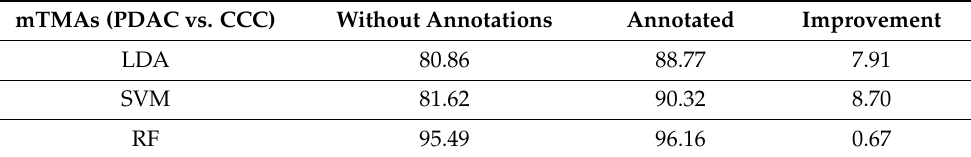
Table 5. Classification accuracies of the different supervised classification models of pancreatic ductal adenocarcinoma (PDAC) versus cholangiocarcinoma (CCC) samples in direct comparison with the same samples with histological annotations of the tumor